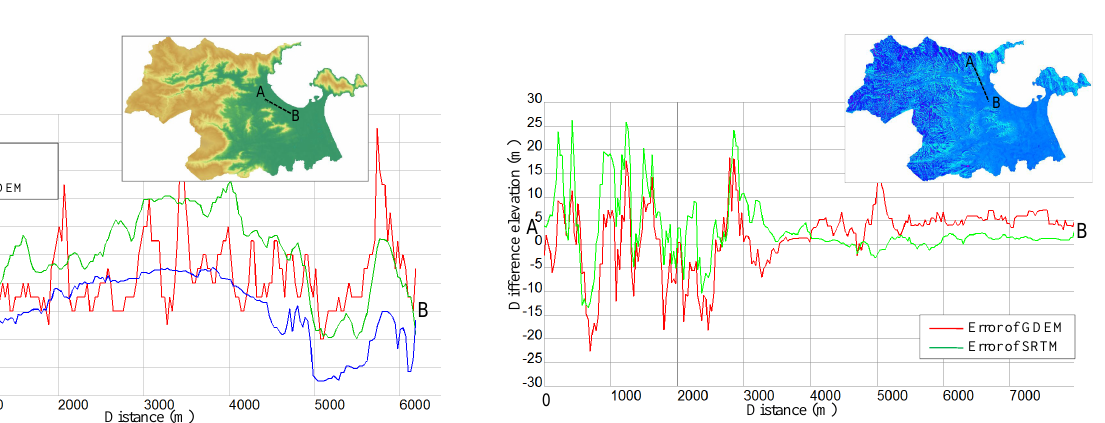
Figure 7. A profile of GDEM and SRTM compared to the reference DEM in flat areas.